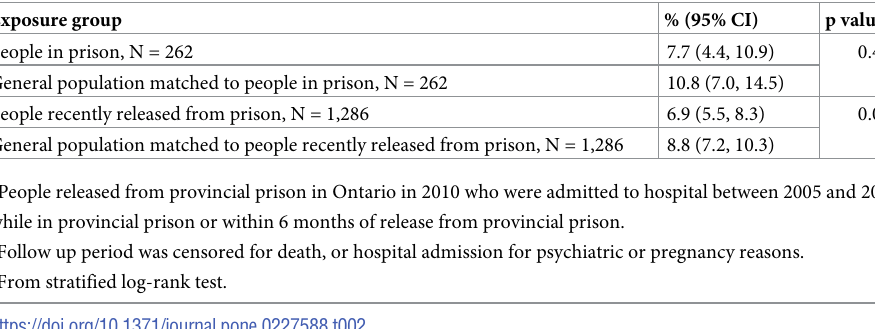
Table 2. Readmission by 30 days after medical-surgical hospitalization for people in prison and people recently released from prison, � and age-, sex-, and case mix group-matched people in the general population, from Kaplan-Meier analyses † .